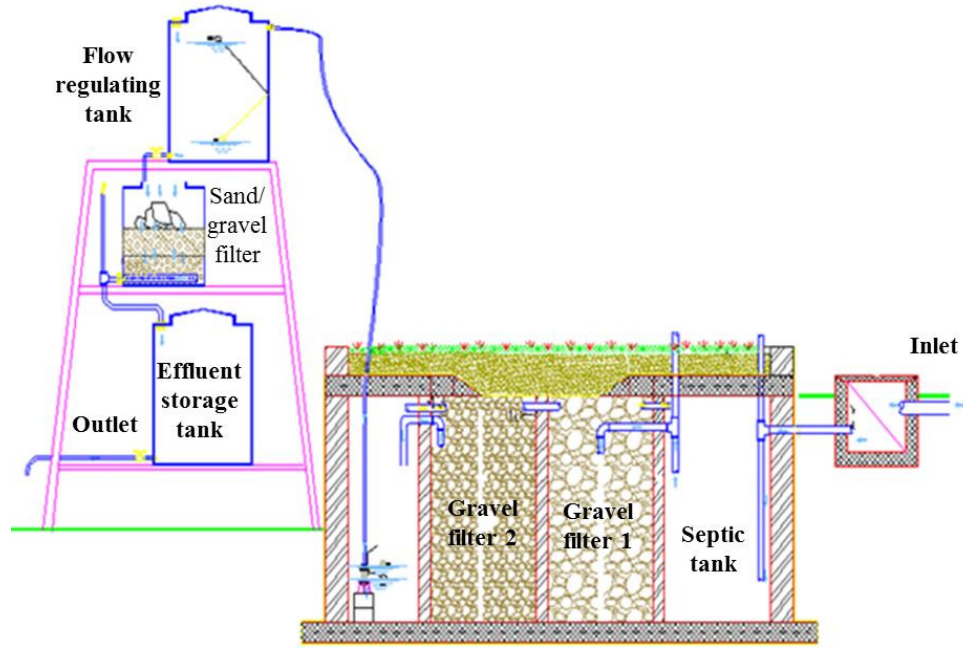
Figure 2. Onsite gray water treatment plant (GWTP) [23].